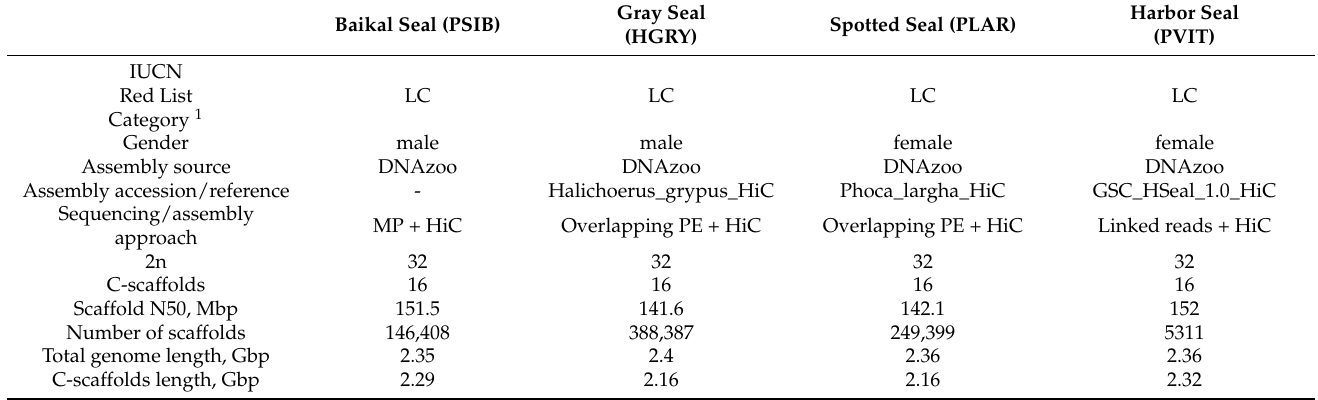
Table 1. General description and quality metrics for genome assemblies of four pinniped species used in this study. MP = mate pair library, PE = paired-end